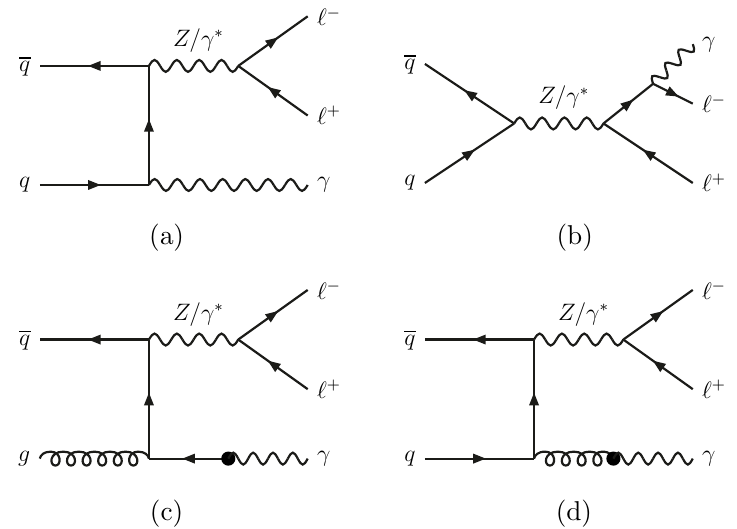
Figure 1 . Feynman diagrams for ‘ + ‘ (cid:0) (cid:13) production: (a) initial-state photon radiation from a quark line; (b) (cid:12)nal-state photon radiation from a lepton; and (c,d) contributions from the Z + q ( g ) processes in which a photon is produced from the fragmentation of a quark or a